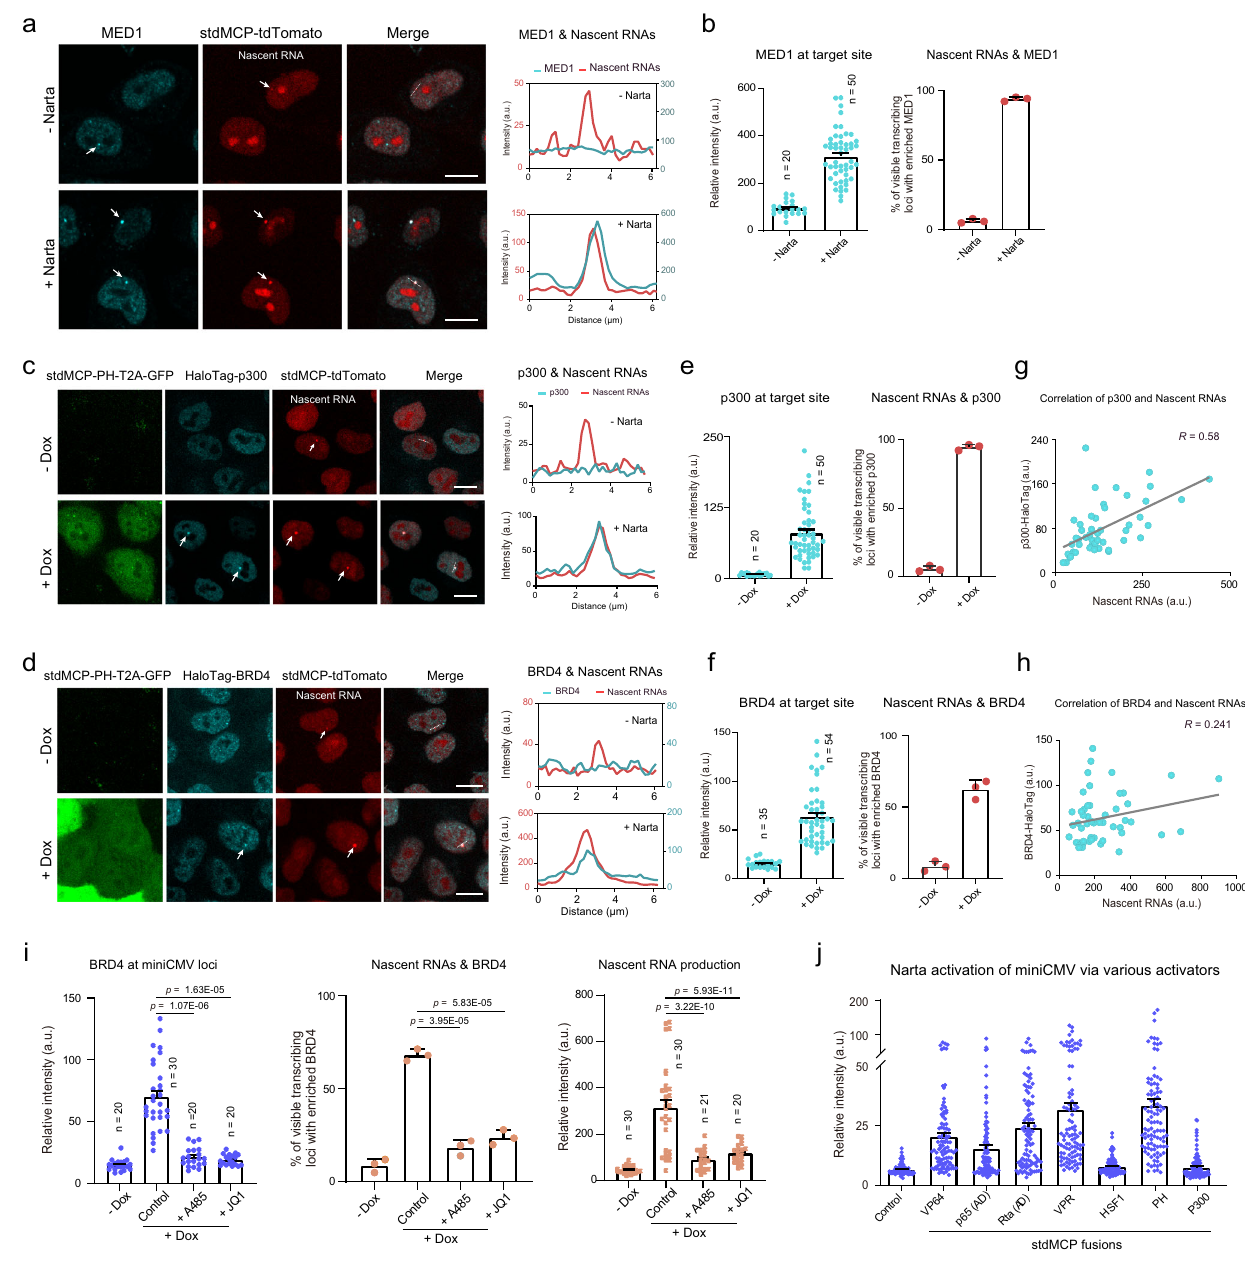
Fig. 6 | Narta can induce high-density assembly of coactivators at target sites. a , c , d Left,representativeimagestoshowtheco-localizationbetweencoactivators (MED1, p300, or BRD4) and nascent RNAs (labeled by stdMCP-tdTomato) pro- ducedby miniCMV. Right, line scan of the relative fl uorescenceintensity indicated bythedottedlinesintheleftpanel.In a stdMCP-PHwastransfectedtoinduceNarta activation,whilestdPCP-PHtranfectionwasusedasthenegativecontrol.In d , f the expression of stdMCP-PH was induced by the addition of Dox. MED1 was detected by antibody, while p300 andBRD4were endogenouslytagged with HaloTag.Scale bar, 10 μ m. b , e , f , Left, total intensity of activator reporters (MED1-Alex647, HaloTag-p300 and HaloTag-BRD4, respectively) enriched at visible miniCMV transcribing loci. Right, quanti fi cations showing the percentage of visible stdMCP- stdTomato spots(representing active mimiCMVloci)whichwere co-localized with enriched signal of coactivators (MED1, p300 or BRD4). n =3 biological replicates.